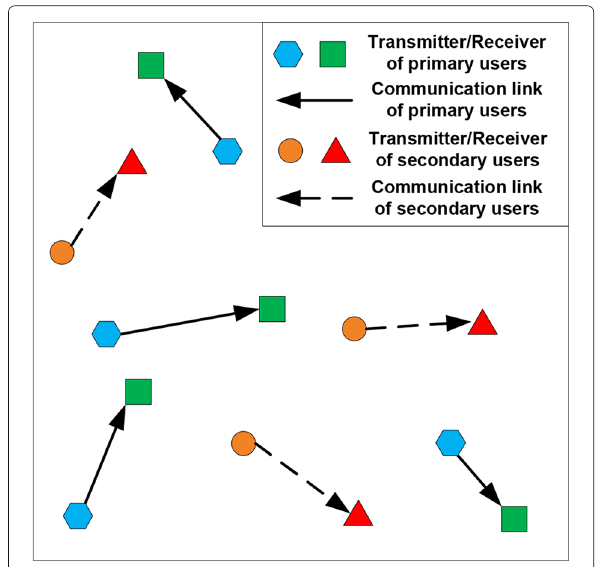
Fig. 1 Scenario of cognitive radio networks